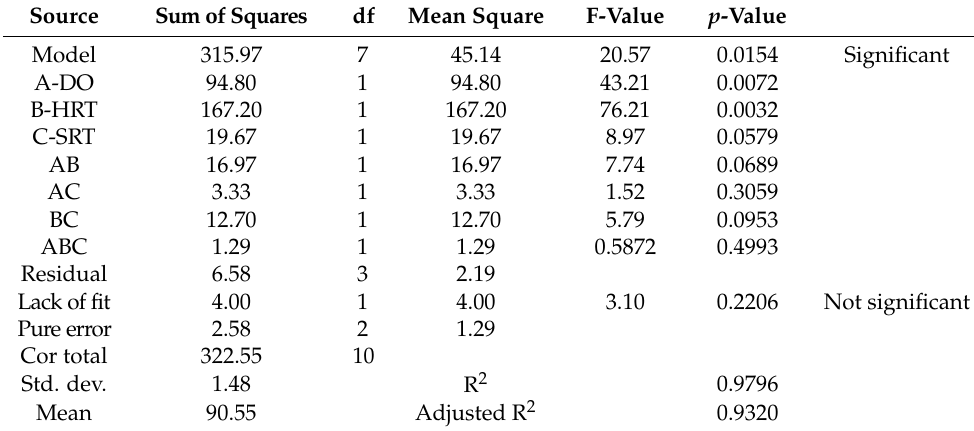
Table 6. ANOVA results for ammonia removal